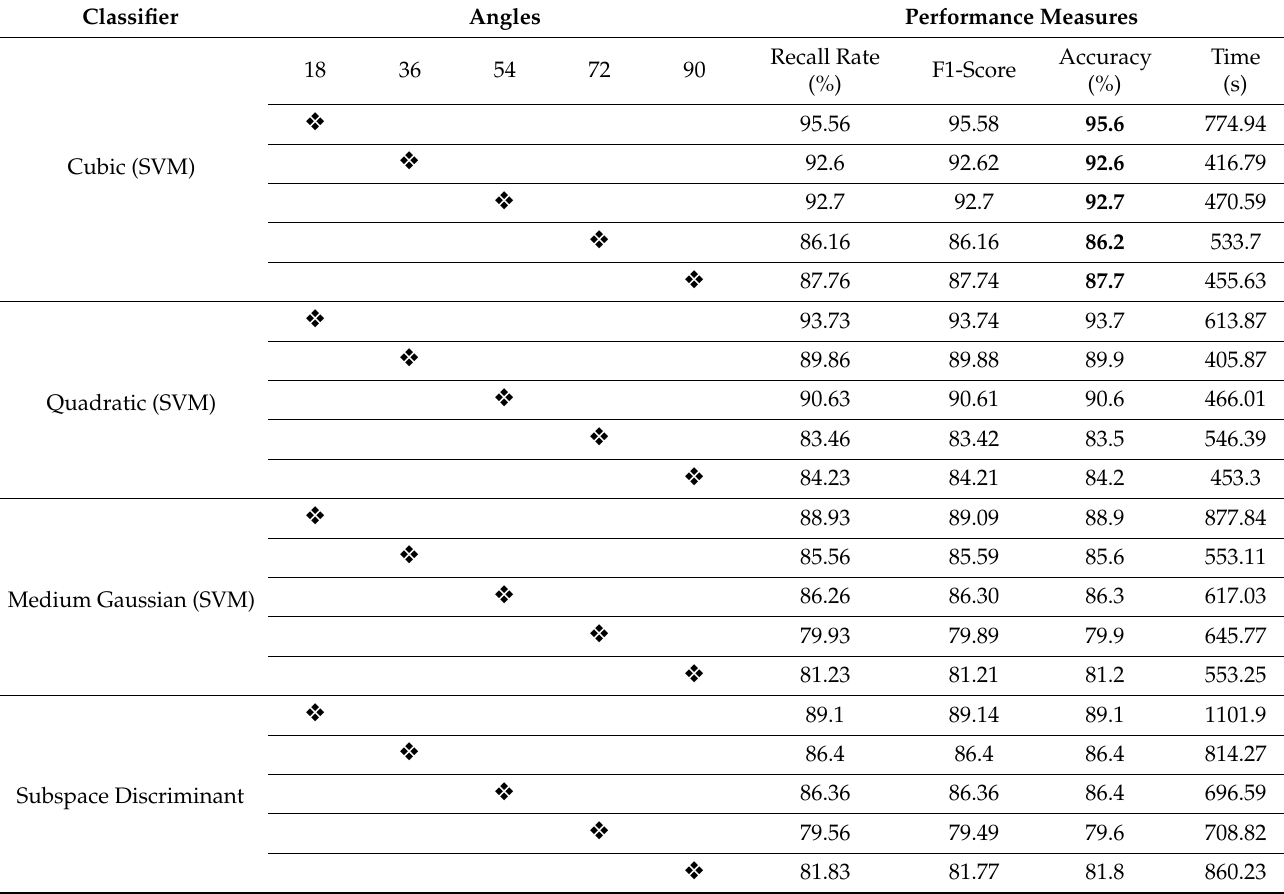
Table 4. Gait recognition results using modified Inception-ResNet V2 on selected angles of the augmented CASIA B dataset.